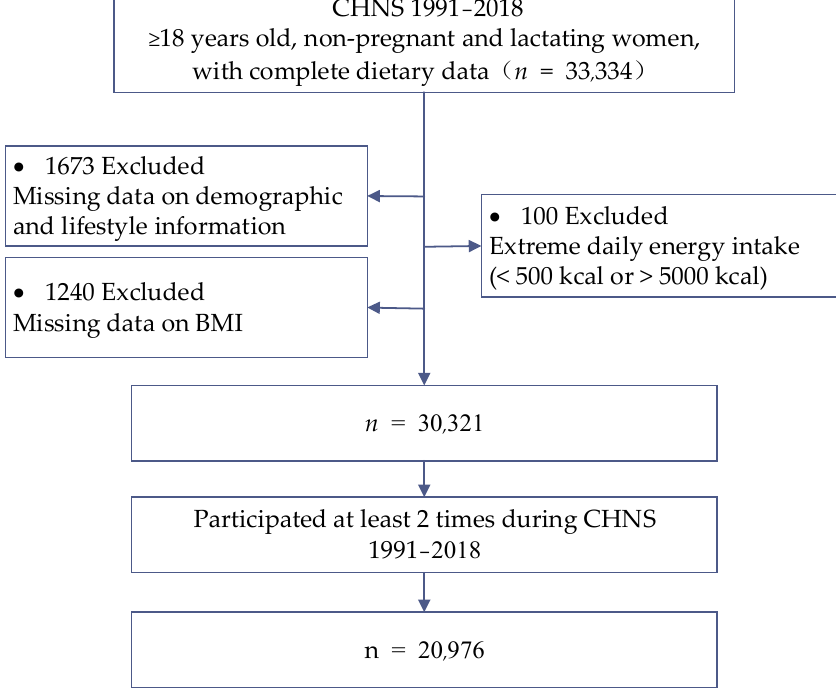
Figure 1. Flow chart of study population.